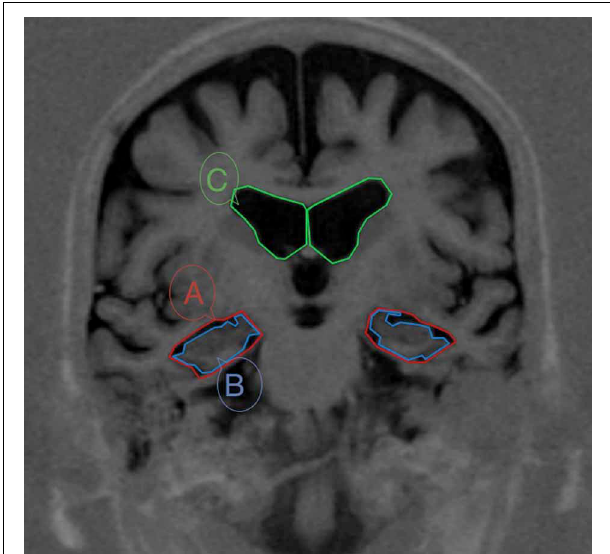
FIGURE 1 | MRI from a patient with MCI with boundaries of the three areas needed for calculating the Medial Temporal Atrophy index (MTAi). The section passes through the interpeduncular fosae. The three areas are: (1) the medial temporal lobe region (A) , defined in a coronal brain slide as the space bordered in its inferior side by the tentorium cerebelli, in its medial side by the cerebral peduncles, in its upper side by the roof of the temporal horn of the lateral ventricle and in its lateral side by the colateral sulcus and a straight-line linking the colateral sulcus with the lateral edge of the temporal horn of the lateral ventricle; (2) the parenchima within the medial temporal region, that includes the hippocampus and the parahippocampal girus (B) ; and (3) the body of the ipsilateral lateral ventricle (C) .